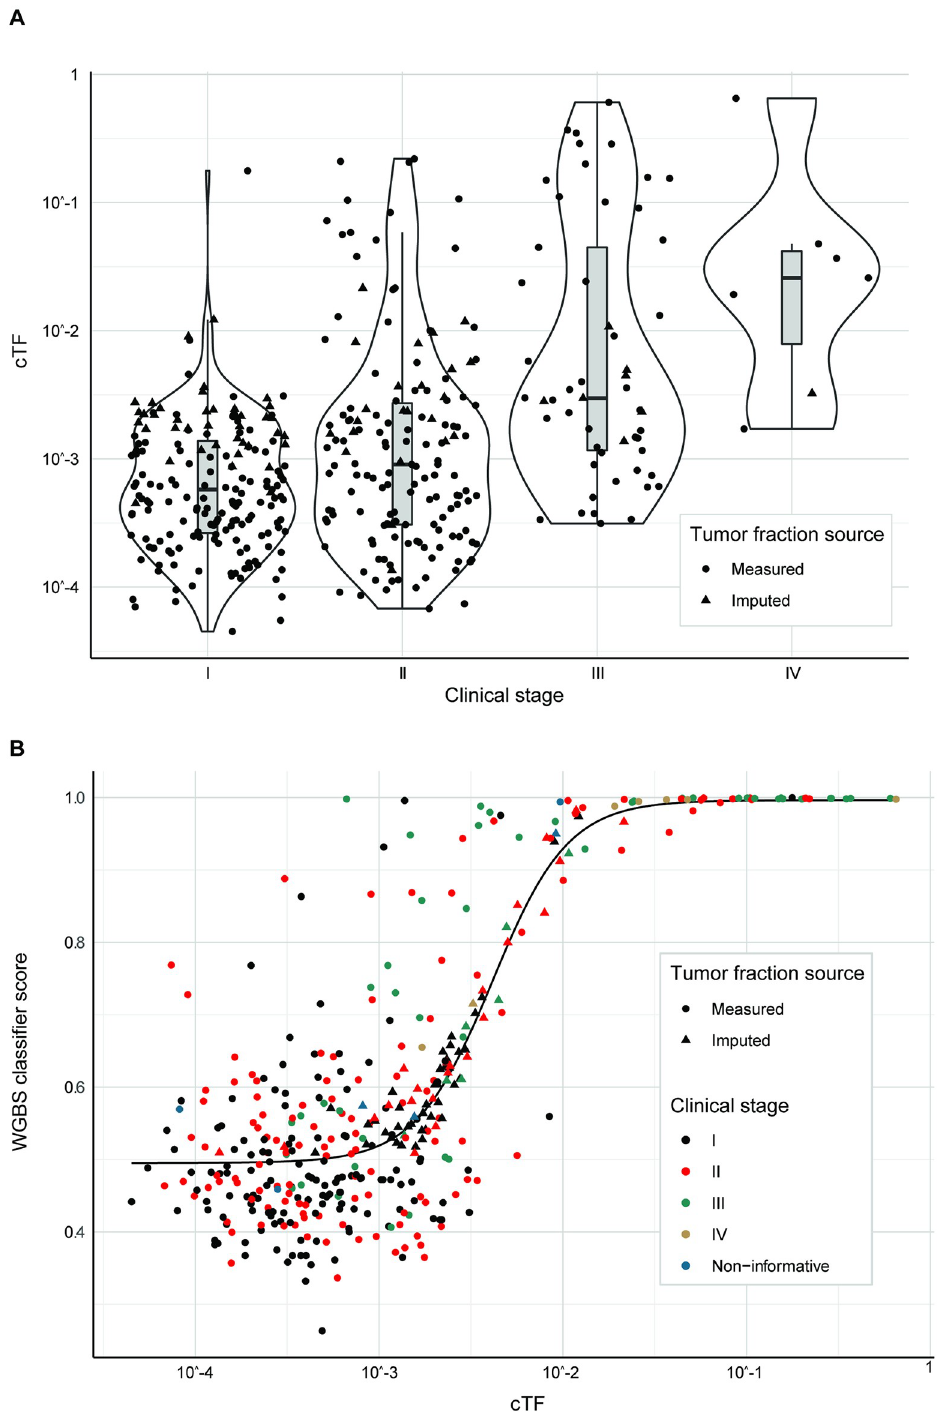
Fig 4. Breast cancer cTF by clinical stage and relation to WGBS classifier score. (A) cTF by clinical stage for breast cancer. (B) WGBS classifier score [26] by cTF for breast cancer. Samples are colored by clinical stage and samples with imputed cTF are shown as triangles. cTF: Circulating Tumor fraction, WGBS: Whole-genome bisulfite sequencing. Non-informative: Confirmed invasive cancer with insufficient clinical information to determine stage.